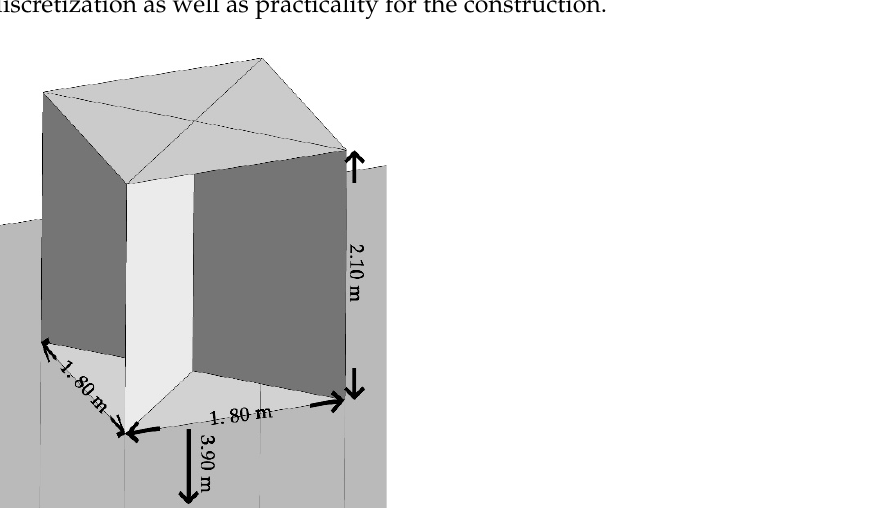
Figure 3. Boundary dimensions of the wind catcher geometry (base case).